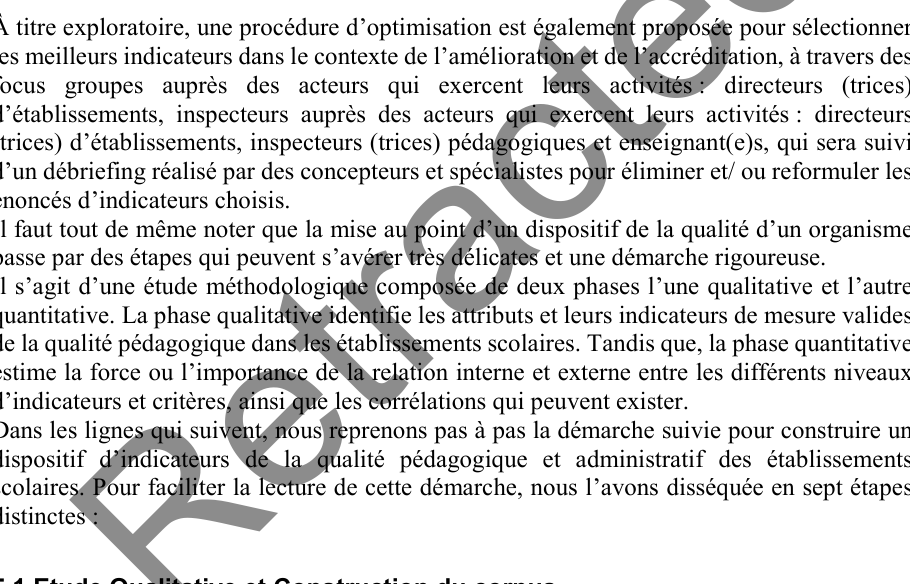
Figure 1 : Démarche de Paradigme de CHURCHILL